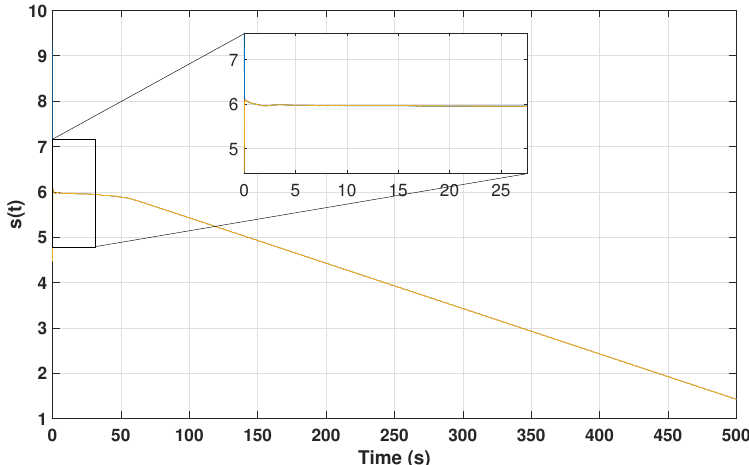
Figure 6. Switching functions s i ( t ) for each agent with the distributed sliding-mode extremum- seeking control. The sliding-mode existed during the search phase (zoomed figure).